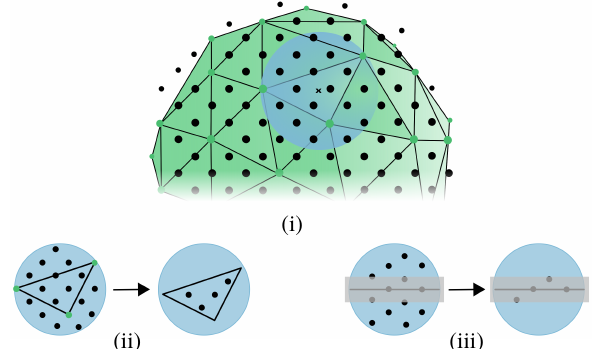
Figure 3. Steps (i) - (iii) of the association